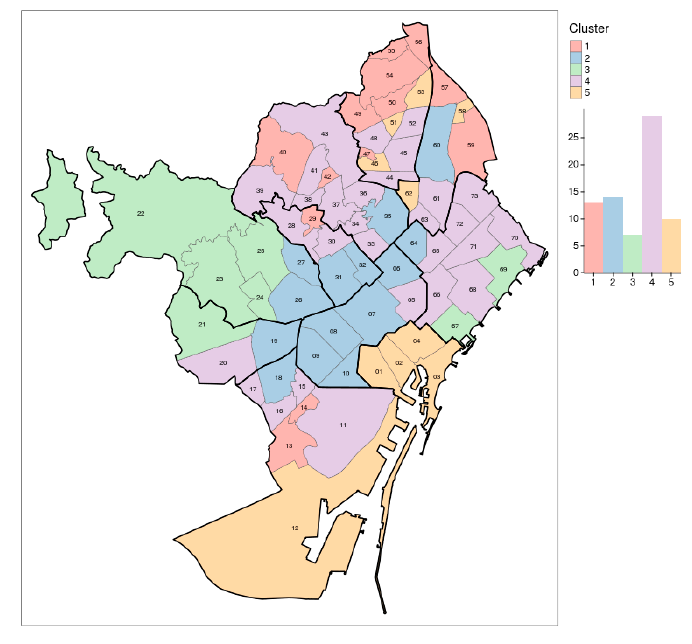
Figure 3. Maps of clusters.